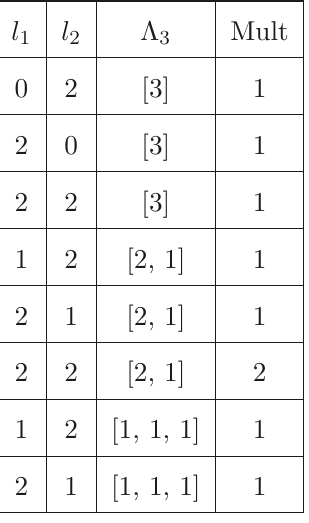
Table 8 . Results for n = 3 fields and k = 4